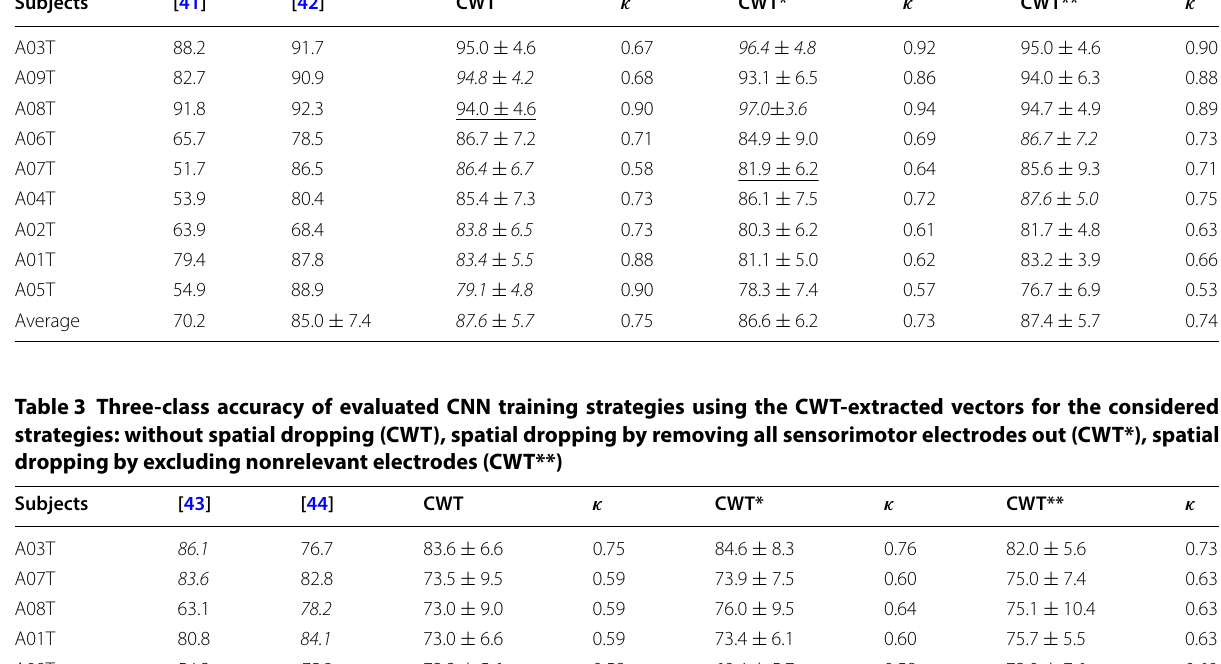
Table 2 Bi-class accuracy of evaluated CNN training strategies, using the CWT-extracted vectors and either dropping strategy: CWT* with sensorimotor electrodes and CWT** with thresholding. In all compared cases, both sub-bands ( µ and β ) are included and the CNN parameters are tuned individually Subjects